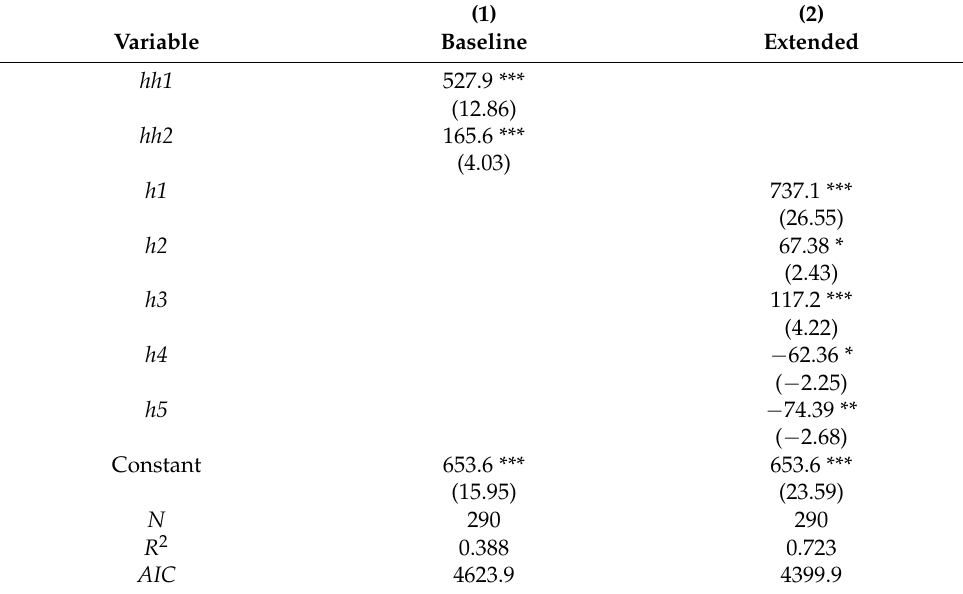
Table 3. Regression